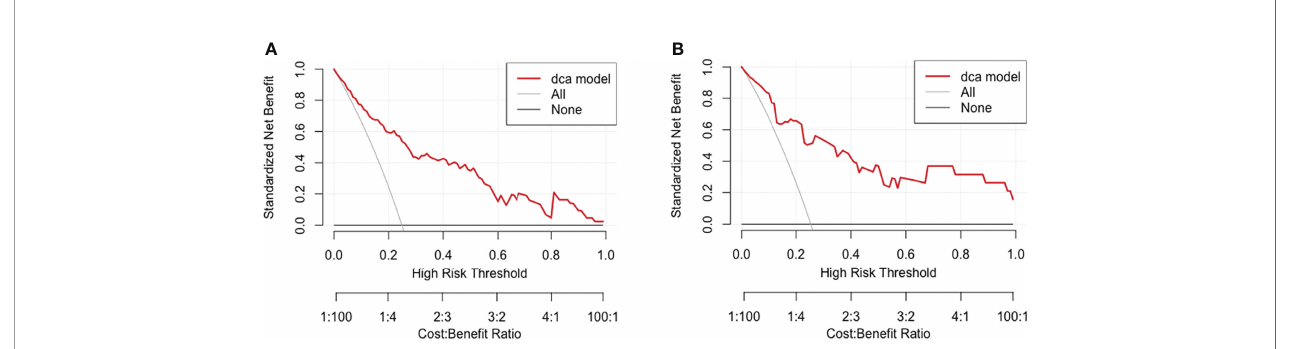
FIGURE 6 | Decision curve analysis for MMN risk nomogram in (A) training group and (B) test group. The y-axis tested the net bene fi t. The thin gray line meant the assumption that all patients had MMN, while the thick red line represented the assumption that all patients had IMN. The dotted line represented the risk nomogram. In training group, the decision curve showed that if the threshold probability of a patient is between 0.01 and 0.93, using the nomogram in the present study to predict MMN adds more bene fi